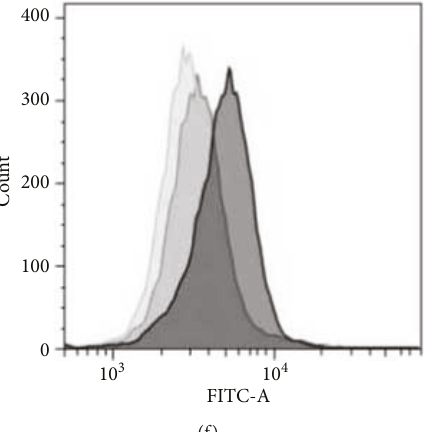
Figure 3: (a) Change in the shape and granularity of PMN after C5a stimulation. In fl uence of 1 minute C5a 100ng/ml exposure on SSC-A (indicator for granularity) and FSC-A (indicator for changes in cell shape) on human PMN. (b) C5a-induced change in cell shape cannot be achieved by forced depolarization. Change in FSC-A for human PMN ( n =10 – 12) after incubation with 10 minutes in bu ff ers plus 1 minute of C5a 100 ng/ml. (c) Independency of cell shape from membrane potential. Di ff erence of membrane potential in human PMN subgroups ( n =10 – 12). Shown is the relation between the 25% upper and lower part of cells in relation to the average fl uorescence. (d) C5a-induced change in cell granularity cannot be achieved by forced depolarization. Change in SSC-A for human PMN ( n = 10 – 12) after incubation with 10 minutes in bu ff er plus 1 minute of C5a 100 ng/ml exposure = 11 minutes in total. (e) Independency of cell granularity from membrane potential. Di ff erence of membrane potential in human PMN subgroups ( n = 10 – 12). Shown is the relation between the 25% upper and lower part of cells in relation to the average fl uorescence. (f) Representative illustration of determination of membrane potential. DiBAC (3) ’ s fl uorescence was measured in the FITC channel. Each sample consists of Ctrl (PMN in K4.5 =light gray), PMN 4 exposed to C5a 100 ng/ml in K4.5 for one minute (gray), and PMN incubated in K15 (dark gray). ∗ p < 0 05 , ∗∗ p < 0 01 , and ∗∗∗ p < 0 001 .